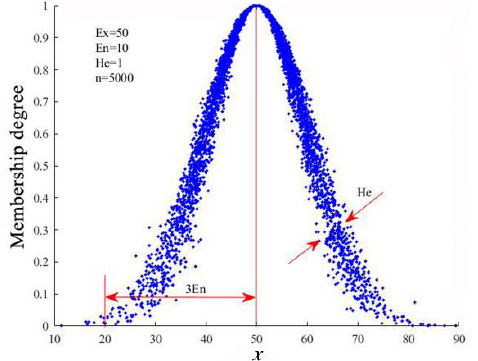
Figure 2. Feature picture of cloud model.